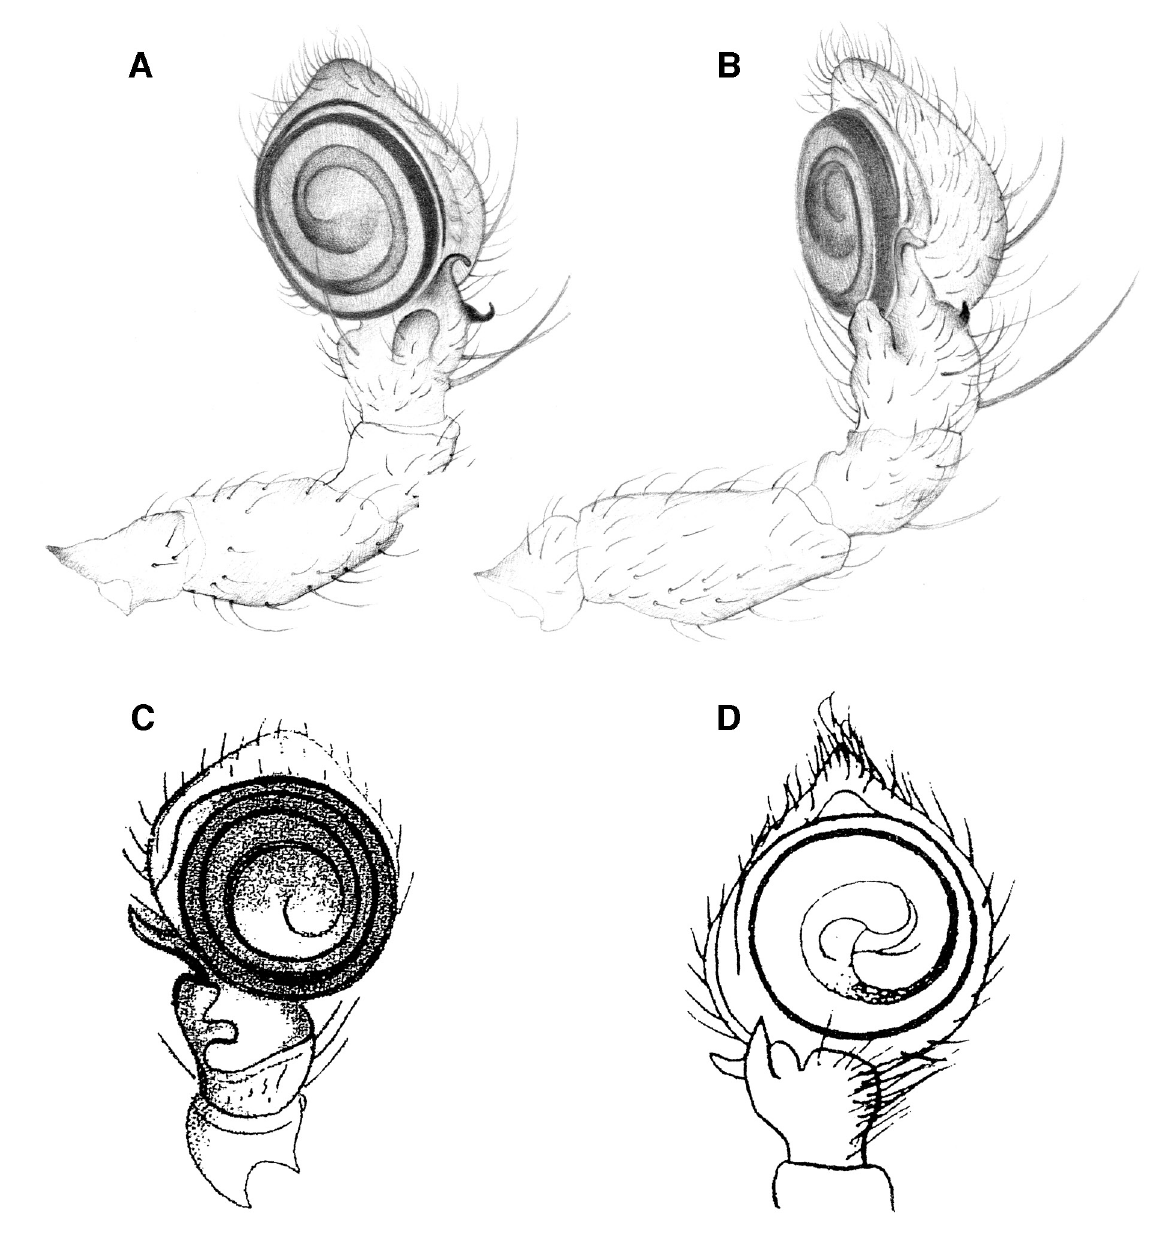
Fig. 4. — A-B. Tmarus galapagosensis sp. nov., ♂. A . Palp, ventral view. B . Palp, retrolateral view. — C-D. Tmarus stolzmanni Keyserling, 1880, ♂ . C . Palp, ventral view after Keyserling (1880). D . Palp, ventral view after Banks